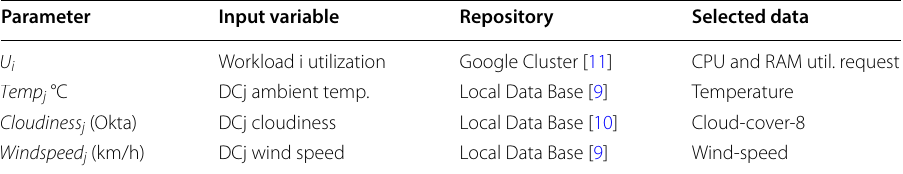
Table 6 Input variables of prediction